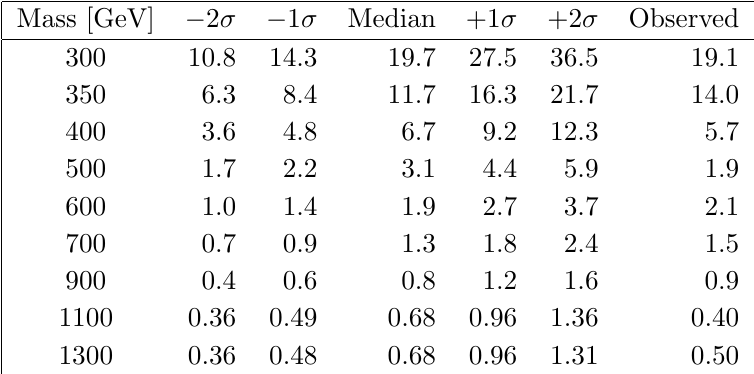
Table 1 . Expected and observed 95% CL upper limits on (cid:27) (pp ! bA = H + X) B (A = H ! bb) in pb as a function of m A = H .